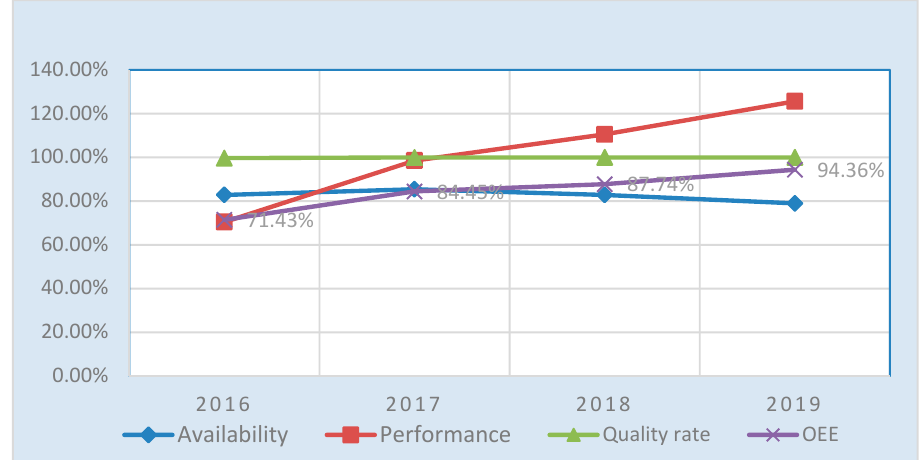
Figure 7. The evolution of the OEE and its